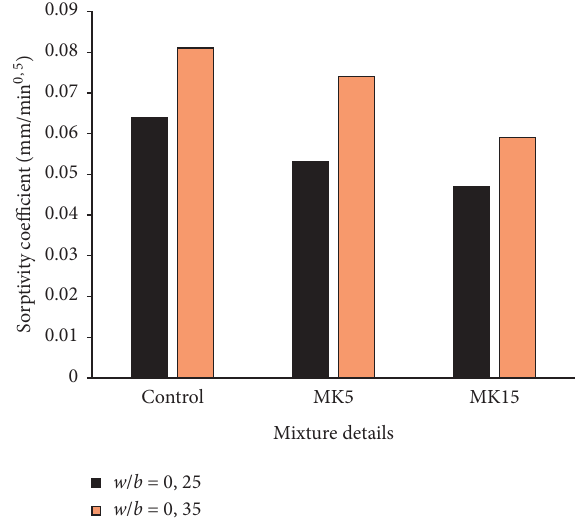
Figure 13: Effect of admixtures on the sorptivity coefficient of concrete